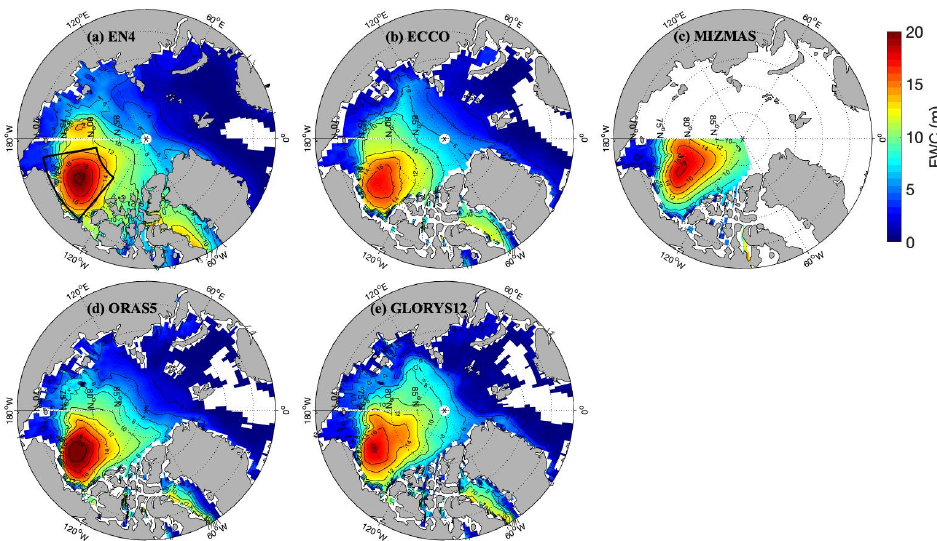
Figure 12. Freshwater content (FWC; m) from 5 m–500 m depth in the Arctic Ocean and averaged between 2012–2017 from the ( a ) EN4 data and five models: ( b ) ECCO, ( c ) MIZMAS, ( d ) ORAS5, and ( e ) GLORYS12. FWC is contoured every 2 m with a reference salinity of 34.8 psu. Beaufort Gyre region is outlined in a black box (Figure 12a).